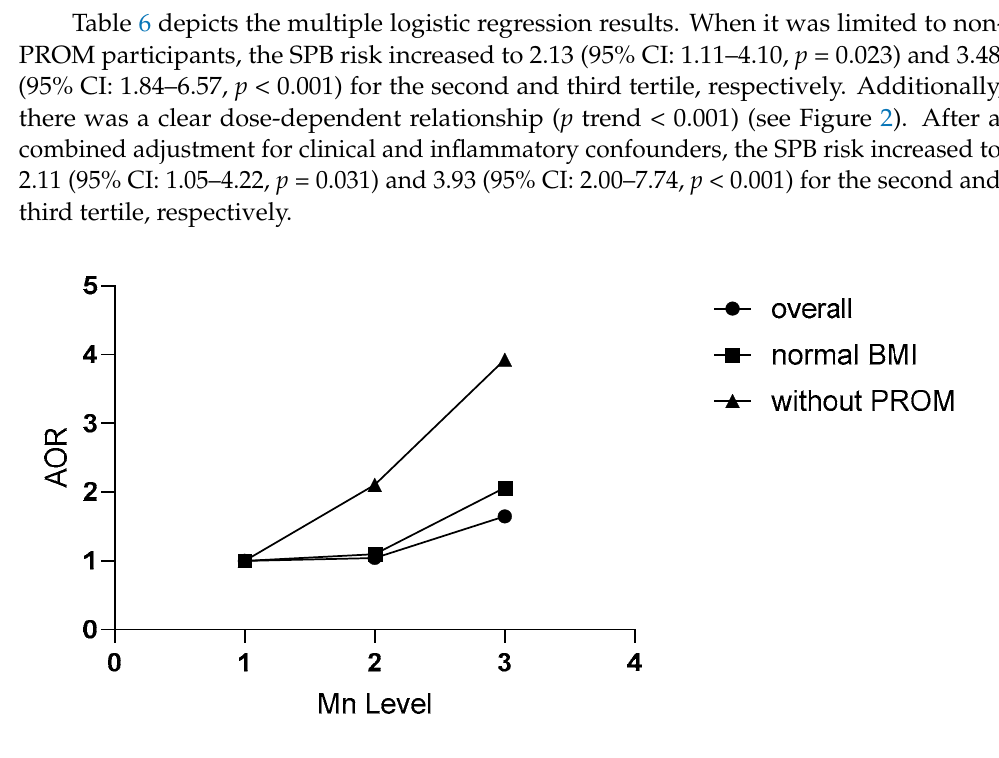
Figure 2. Relationships of maternal plasma Mn in the third trimester with SPB in different populations. Plasma Mn concentration was classified into three levels by the tertile of all subjects (L1, L2, and L3). Without PROM refers to the population without premature rupture of membranes (PROM); normal BMI refers to the people with a pre-pregnancy body mass index (BMI) in the 18.5– 23.9 kg/m 2 range. AOR refers to the odds ratio adjusted for age, BMI, education, economy, nationality, parity, gravida, fetal gender, blood week, and inflammatory factors related to SPB in routine blood tests. SPB: spontaneous preterm birth.